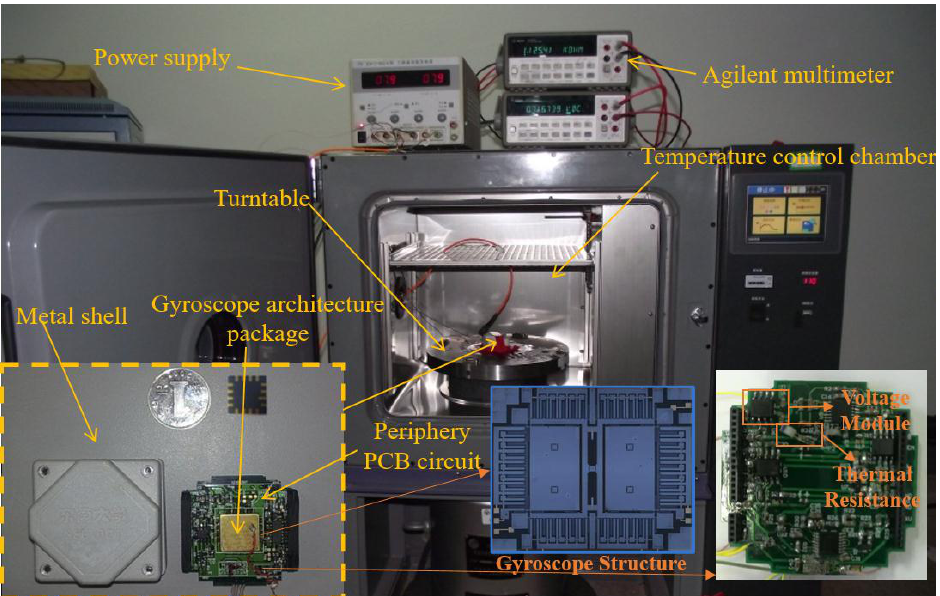
Figure 9. MEMS gyroscope porotype and temperature experiment platform.